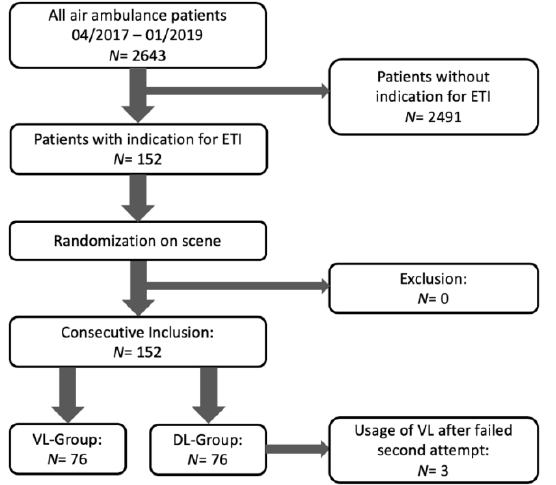
Figure 1. Flow-Chart of patient enrollment.